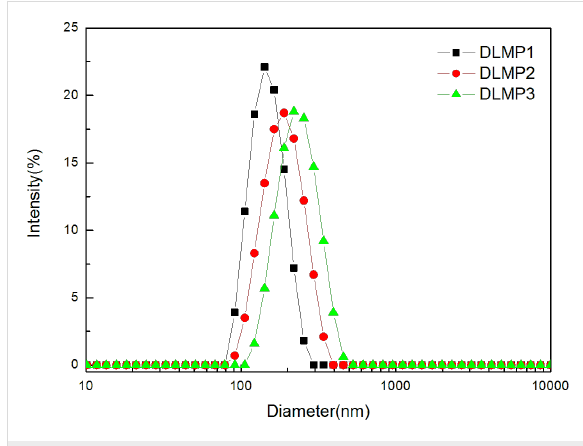
Figure 4: Particle size distributions of DLMP1, DLMP2, and DLMP3 at 25